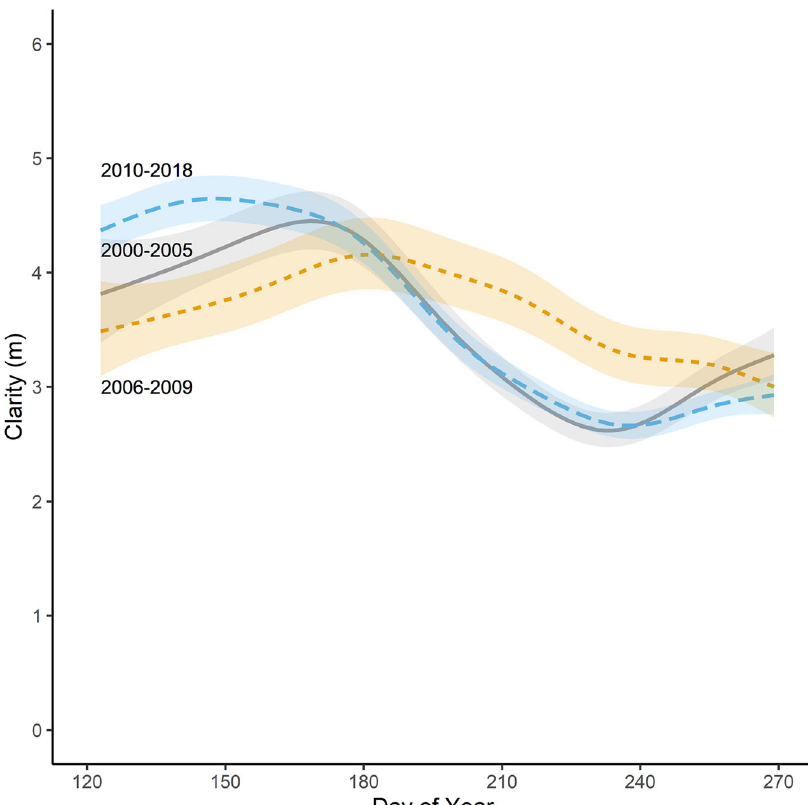
Fig. 3 Water clarity (m) patterns in Lake Mille Lacs prior to Dreissena or Bythotrephes invasion (2000 – 2005), post- Dreissena invasion (2006 – 2009), and post- Dreissena and Bythotrephes invasion (2010 – 2018). Estimates are simulated from the generalized additive model. Con fi dence ribbons are ±1 standard